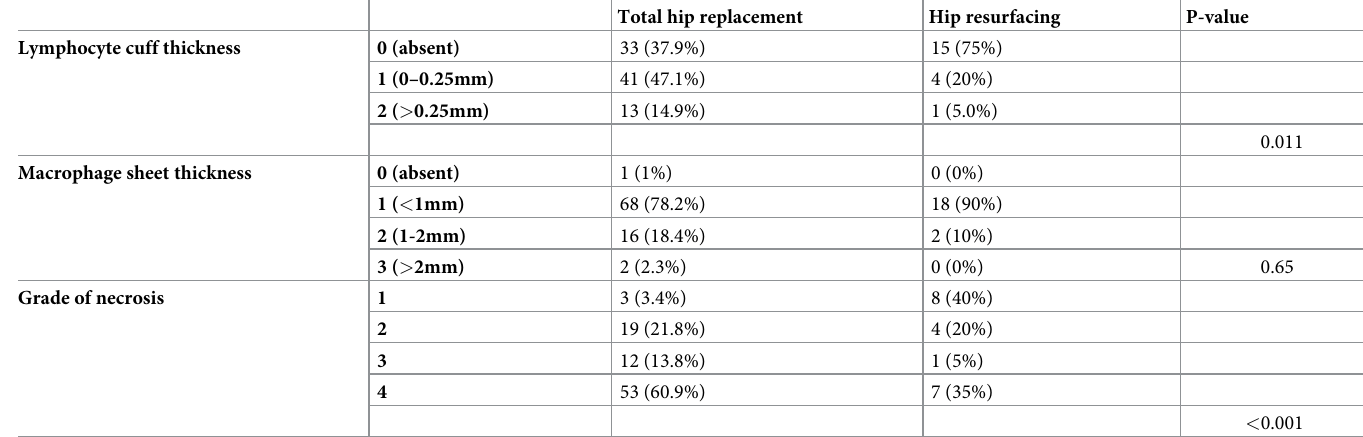
Table 4. Lymphocyte cuff thickness, macrophage sheet thickness and grade of necrosis in total hip replacement group (n = 87) and hip resurfacing group (n = 20).